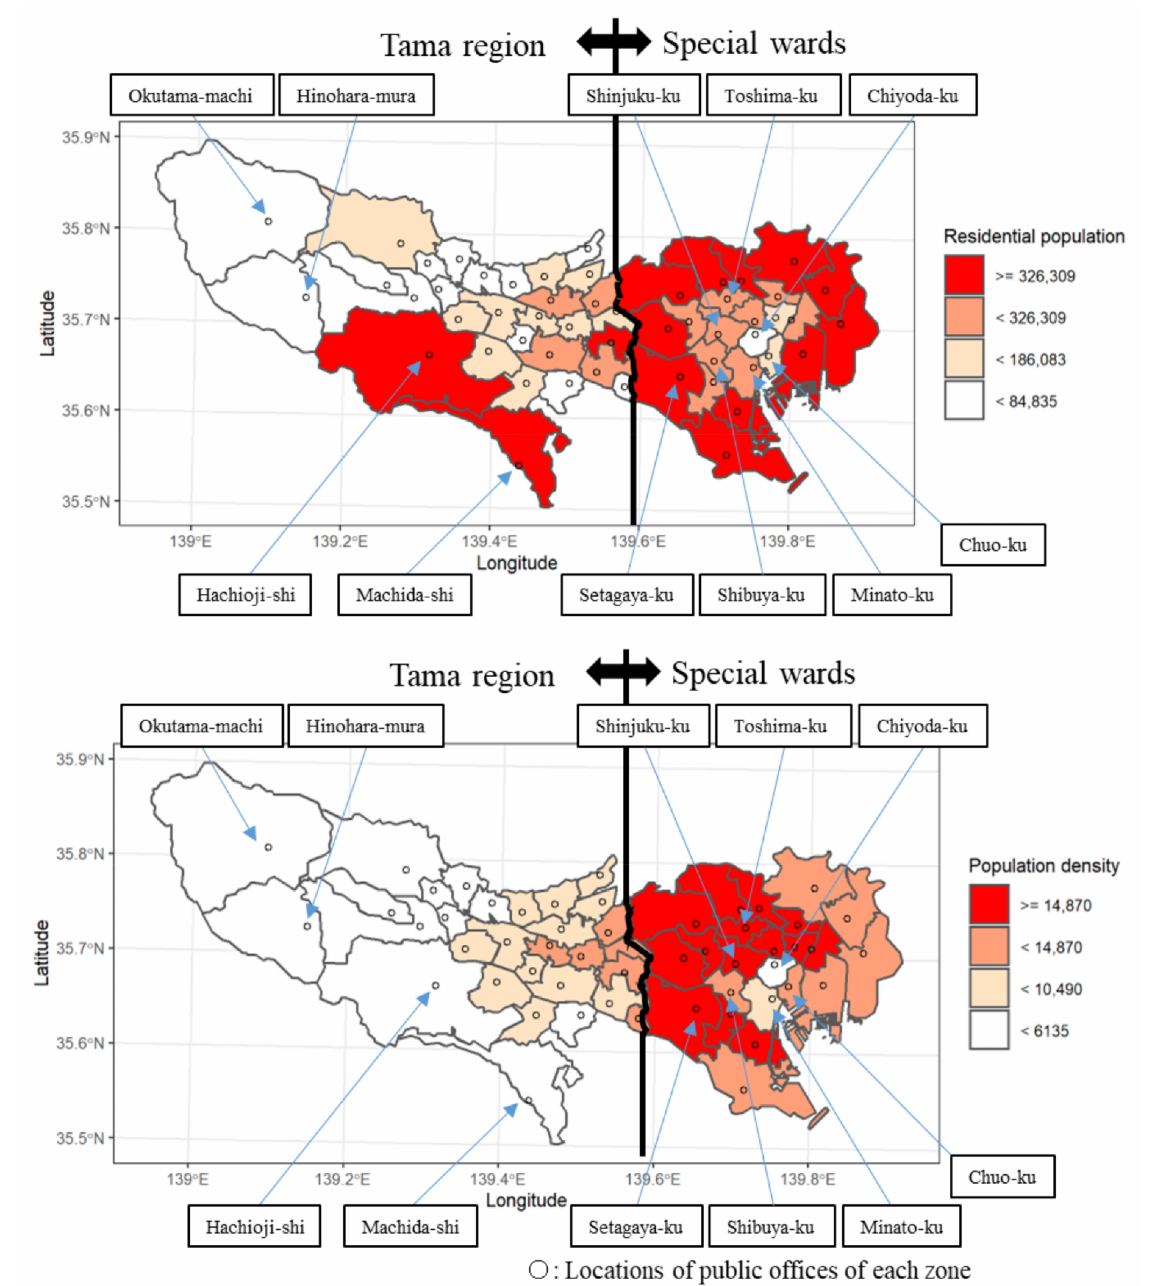
Figure 3. Residential population and population density of each